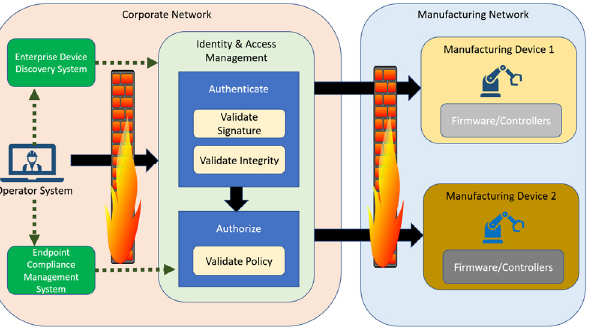
Figure 14. High-level architecture of Zero-Trust Security for Smart Manufacturing .